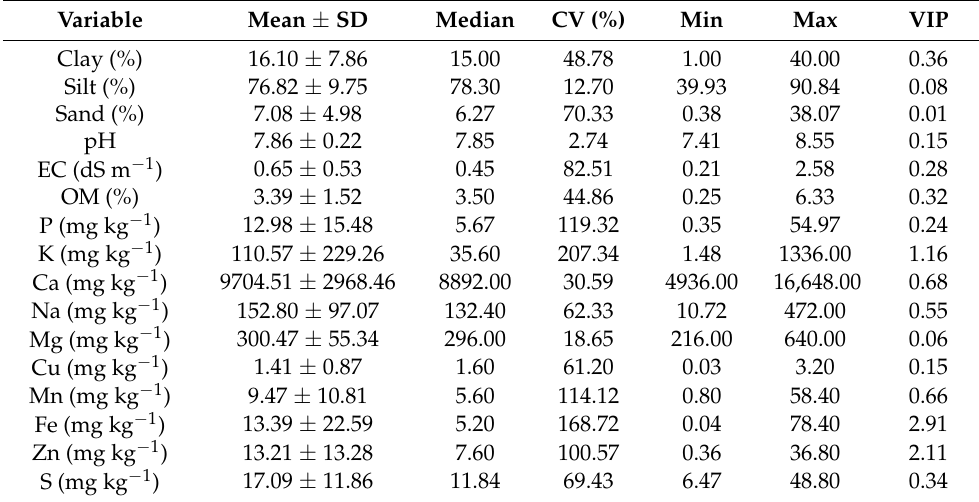
Table 2. Input variables used in model’s construction (mean ± standard deviation, coefficient of variation, maximum and minimum) and the variable importance in the projection (VIP) values obtained from the OPLS-DA